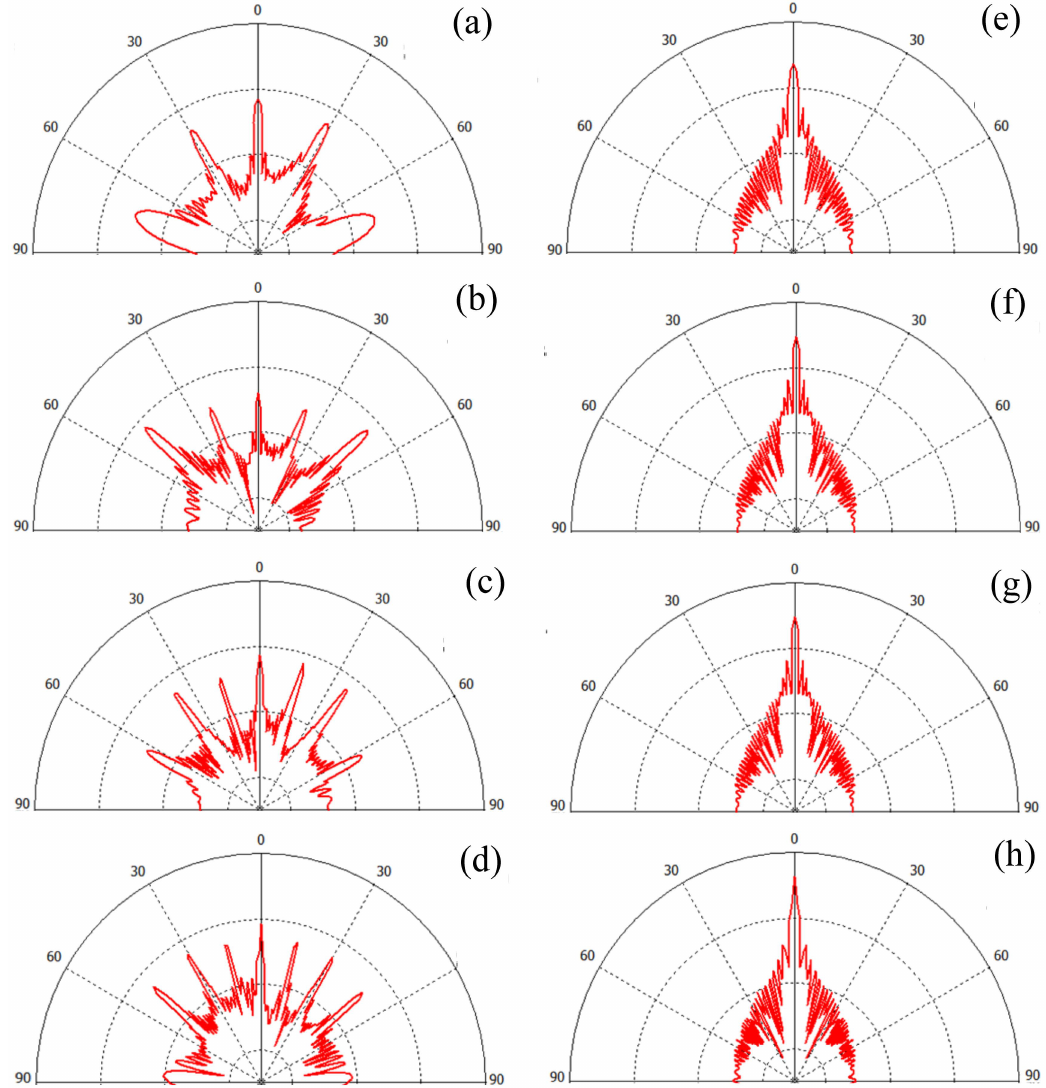
Figure 10. In XOZ -plane, scattering patterns of the designed PCM at ( a ) 18 GHz, ( b ) 25 GHz, ( c ) 32 GHz, ( d ) 40 GHz, and scattering patterns of a bare metal plane at ( e ) 18 GHz, ( f ) 25 GHz, ( g ) 32 GHz, ( h ) 40 GHz.